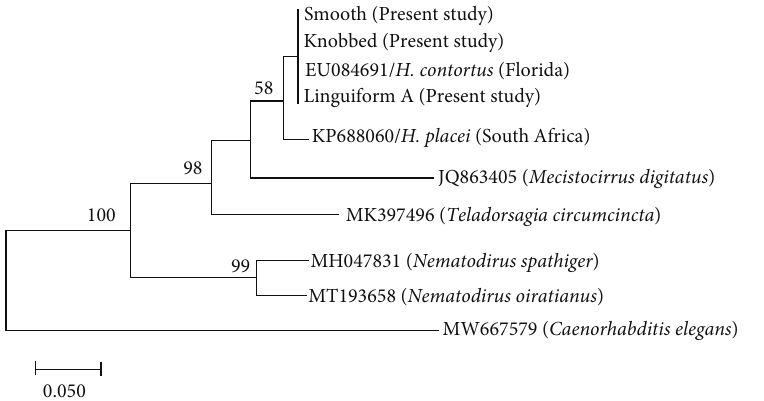
Figure 5: Phylogenetic relationship of H . contortus (present study) showing the relationship with H. placei with other abomasal nematodes (Haemonchidae) based on ITS-2 by BI and ML